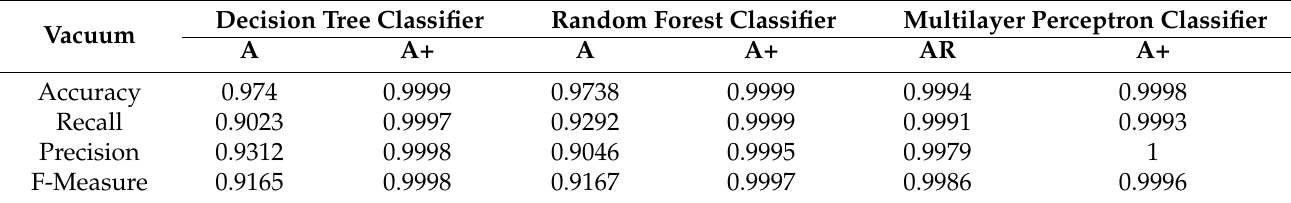
Table 1. Results for the vacuum cleaner. With “A” we refer to the experiments that used only active power. With “AR” we refer to experiments with active and reactive power and with “A + ” we refer to experiments with all the selected attributes.